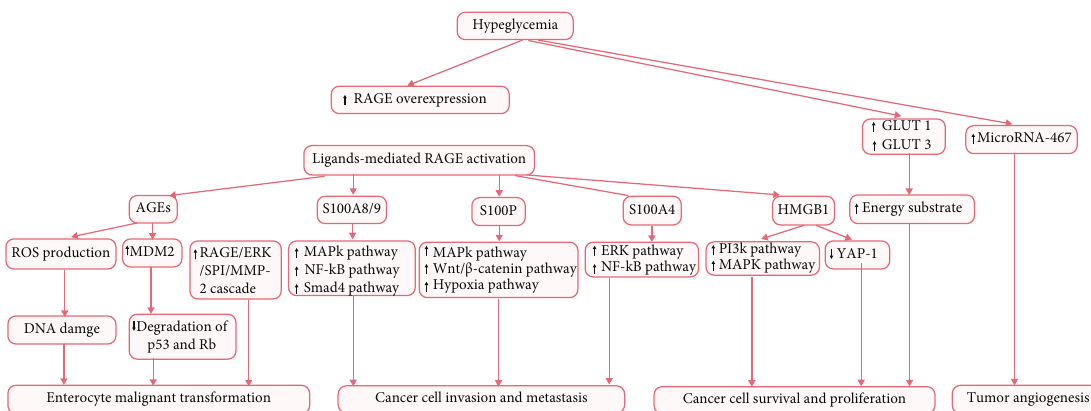
Figure 3: E ff ects of hyperglycemia on colorectal carcinogenesis. RAGE: receptor for advanced glycation end products; AGEs: advanced glycation end products; ROS: reactive oxygen species; ERK: extracellular signal-regulated kinase; SP1: speci fi city protein 1; MMP-2: matrix metallopeptidase-2; MAPK: mitogen-activated protein kinase; NF- κ B: nuclear factor kappa-B; PI3K: phosphatidylinositol 3-kinase; YAP-1: Yes-associated protein-1; GLUT1: glucose transporter 1; GLUT3: glucose transporter